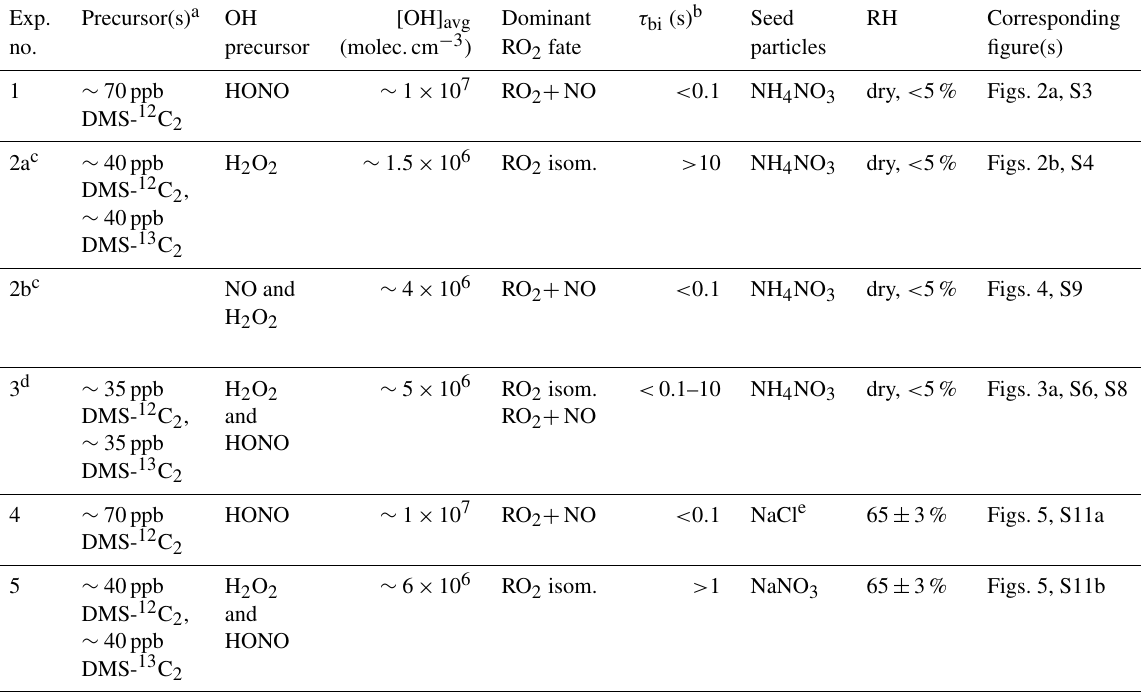
Table 1. Summary of experimental conditions. Exp. RH Corresponding